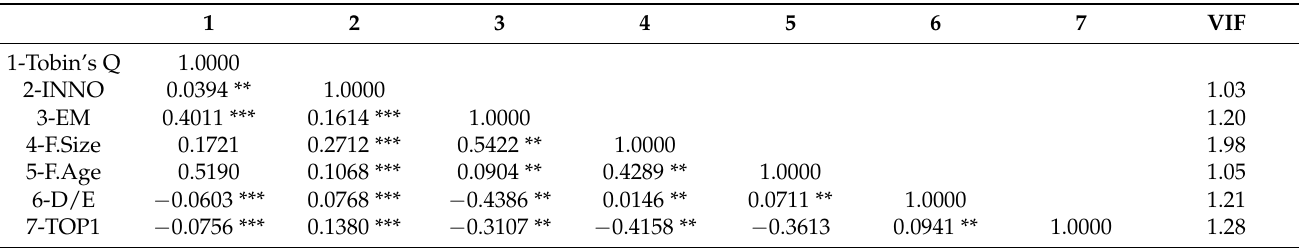
Table 2. Correlation